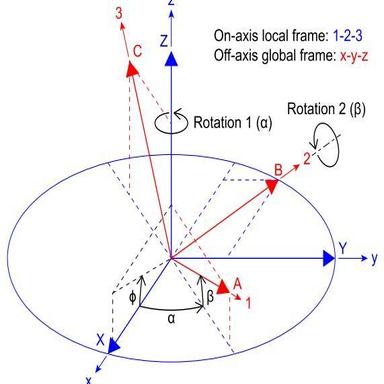
Schematic of the local and global reference frames and Euler angle rotations defined for the stiffness matrix transformation.